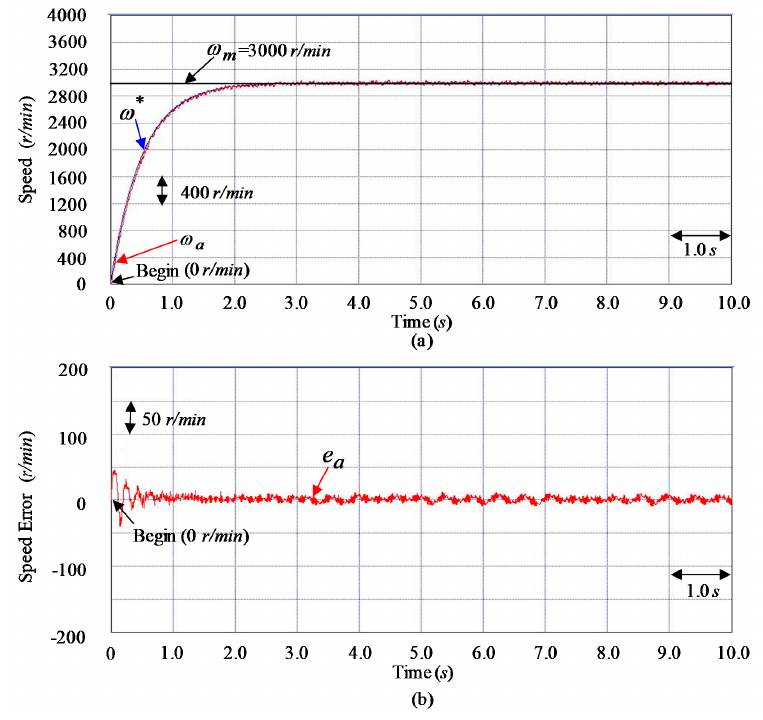
Figure 13. Tested results for the SIM expelling CVT organized system at the tested Event E2 case by using the controller CT3: ( a ) speed response, ( b ) speed discrepancy response .